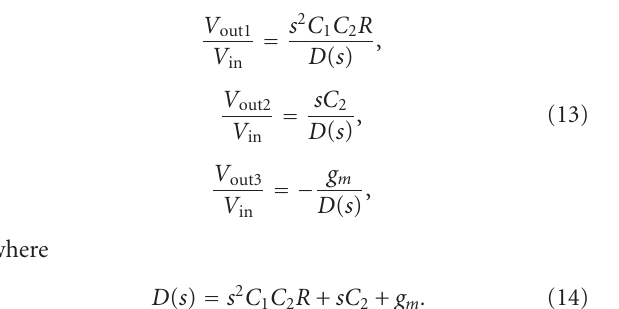
Figure 8: Current mode universal filter. Figure 6. The analysis of circuit yields the output voltages at various nodes